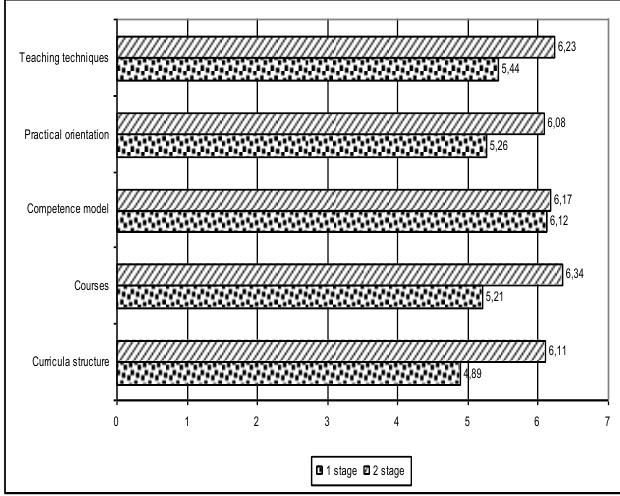
Fig. 2. Evaluation of developed curricula. As it can be seen from Fig. 2, at the second stage of evaluation employers became satisfied with the structure, competence model and teaching techniques provided in the course, and approved the suggested approach for partner universities. For the purpose of this study we have also carried out analysis of correlation between the quality of learning approaches used within the process of education, and the level of employee’s efficiency on the basis of data provided by ten partner companies of the universities. Evaluation of teaching techniques was carried out at the universities (by rating each technique on 7-point Likert scale, where 1 means “the technique is not used, and 7 – this is a basic technique used within educational process), while evaluation of employees performance was provided as average level for 4 – 7 employees, who graduated from this university. The results of correlation analysis (Pearson correlation) are presented in Table